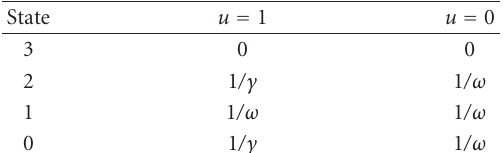
Table 1: One step cost C ( x k , u k ) .